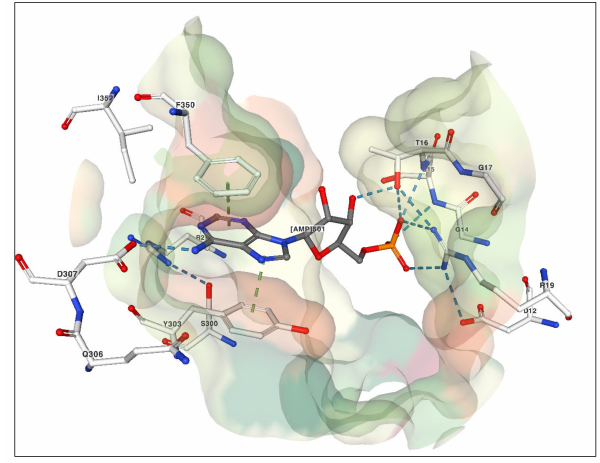
Figure 2. Active site of T. repens APY in complex with AMP. Residues in the active site and AMP (labeled [AMP]501) are shown in ball-and-stick representation (white bonds, residues; gray bonds, AMP). Interactions between residues and AMP are shown as green dashed lines within a rendered molecular surface. The adenine base of AMP is shown sandwiched between Y303 and F360 stabilized by π -stacking interactions. Residue D307 is also displayed. The area occupied by this residue in the active site is postulated to influence substrate affinities and specificities (see text and ref. [41]). This image was created using coordinates from RSCB PDB entry 5U7V [41] with the NGL viewer [52].